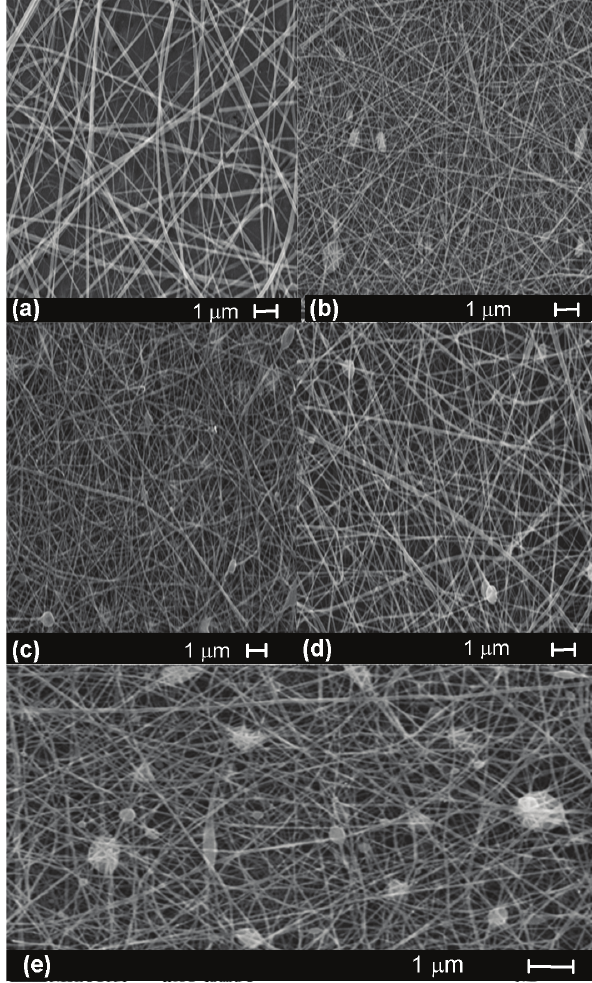
Figure 1: SEM Image of Ag-Doped TiO₂ Nanofibers (a) 1 % Ag, (b) 2% Ag, (c) 3% Ag, (d) 4% Ag, (e) 5% Ag. Table 1: Average diameter thickness, standard deviation, mean value, number of the measured nanofibers, and image analysis of 1, 2, and 3, 4, 5 wt % Ag-doped TiO nanofibers. 2 Ag wt% Fiber Diameter (µm) Measure- Image Area ments Analyzed (%) Average Std. Dev.